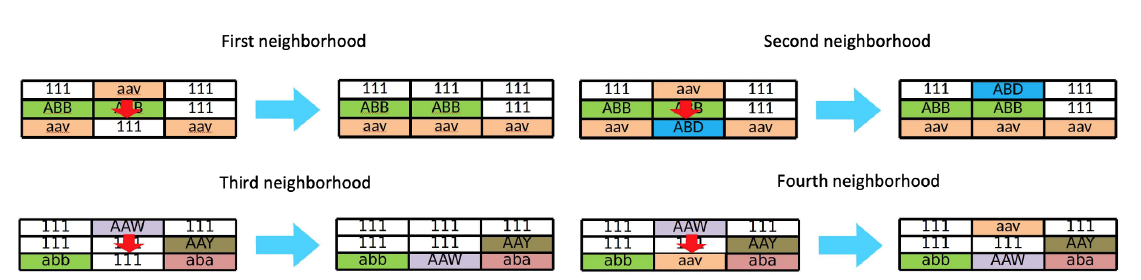
Figure 6. Neighborhood definitions.